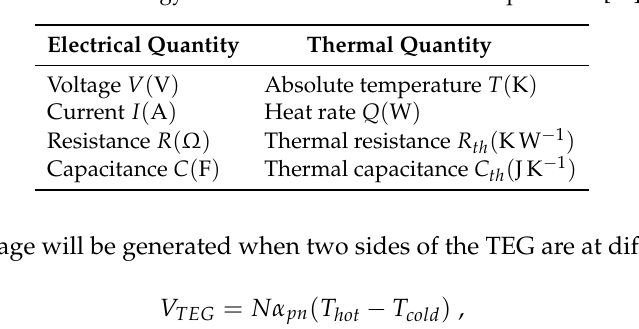
Table 1. The analogy between electrical and thermal quantities